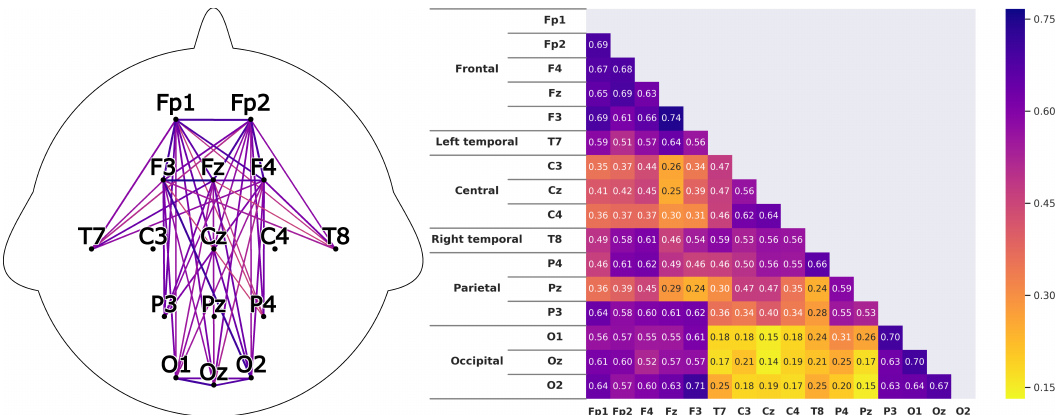
Figure 8. Average correlations of the EEG sensors for the HKT process owner displayed in two differing layouts. On the left through connecting lines. The strength is visible through the color and the thickness of the line. Only the correlations concerning the 5 hypotheses are shown to have a clearer view. On the right, the correlation matrix for all EEG sensors is displayed.